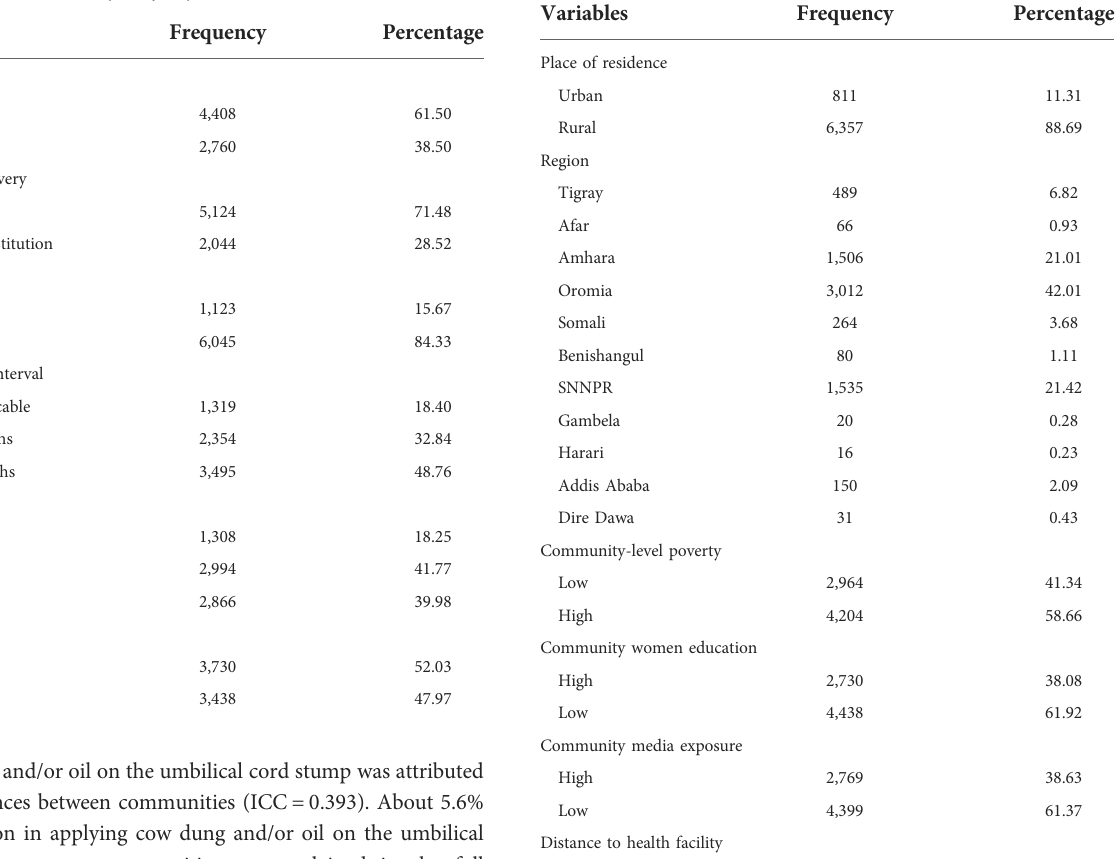
TABLE 2 Reproductive history and their recent child characteristics of women who gave birth within the last fi ve years preceding the survey in Ethiopia, EDHS 2016 ( N